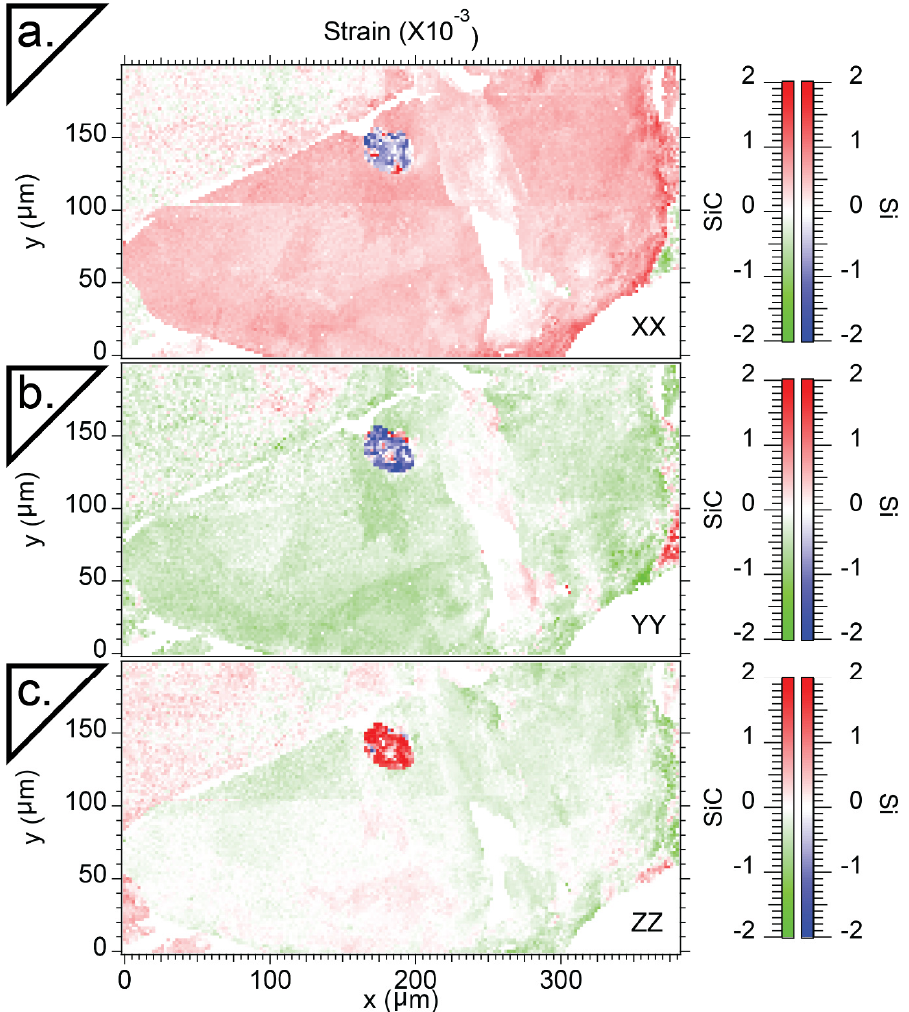
Figure 10. Strain maps of the mixed 4H- / 6H-SiC region and Si inclusion in the ( a ) x (horizontal) ( b ) y (vertical) and ( c ) z (out of plane) directions.